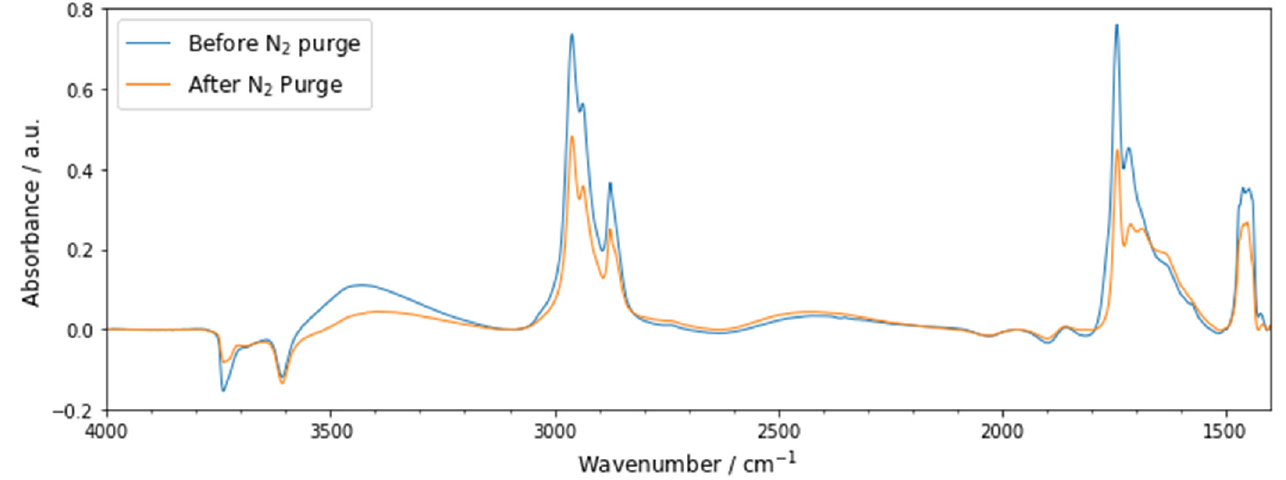
Figure 7. FT-IR difference spectra of H-ZSM-5 SAR80 zeolite doped with methyl n -hexanoate before and after the nitrogen purge.